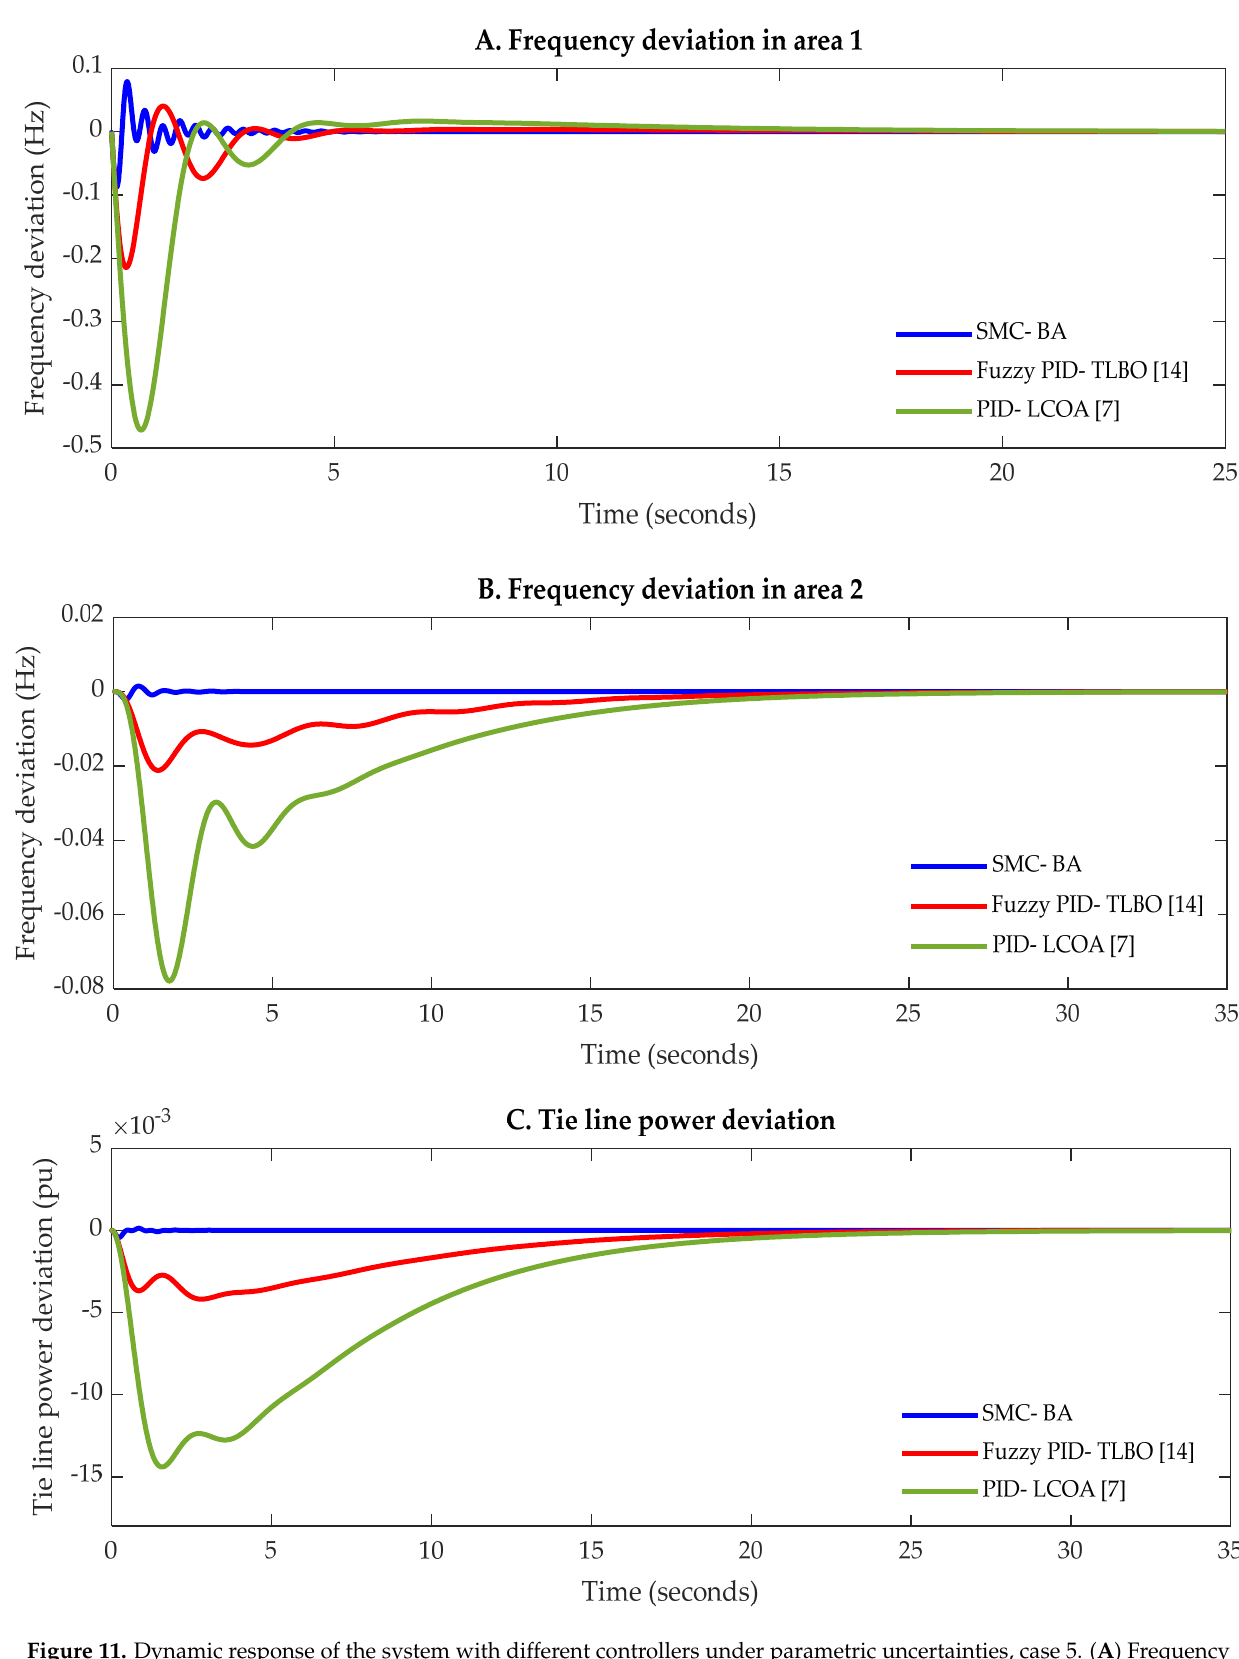
Figure 11. Dynamic response of the system with different controllers under parametric uncertainties, case 5. ( A ) Frequency deviation in area 1; ( B ) Frequency deviation in area 2; ( C ) Tie line power deviation.